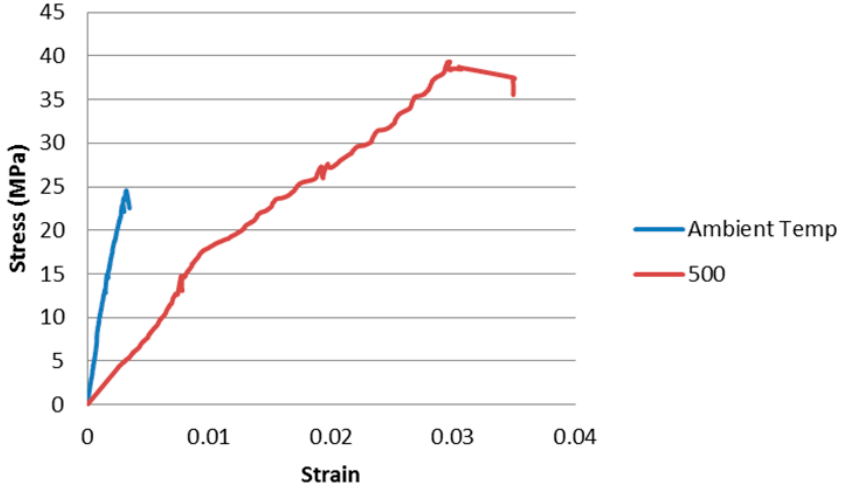
Figure 3. C1.82PP compression test curves undertaken at ambient and 500 °C.